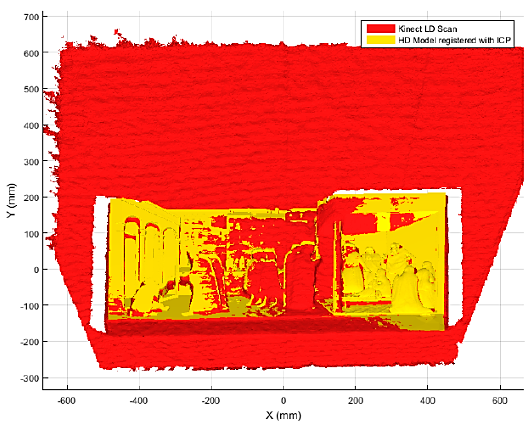
Figure 4. HD and LD bas-relief models after coarse and fine registration (ICP algorithm).